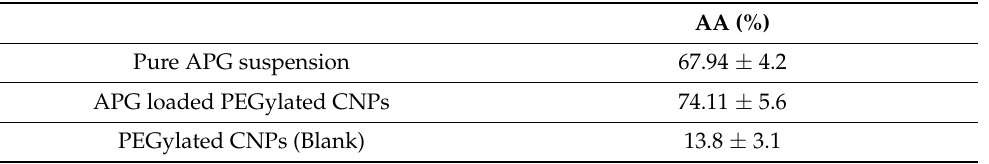
Table 7. In vitro antioxidant activity (% AA) of PEG-CNPs formulation in the presence or absence of APG in comparison with a methanolic solution of the APG and calculated as the inhibition percentage of DPPH radical. Data are expressed as mean ± SD ( n =